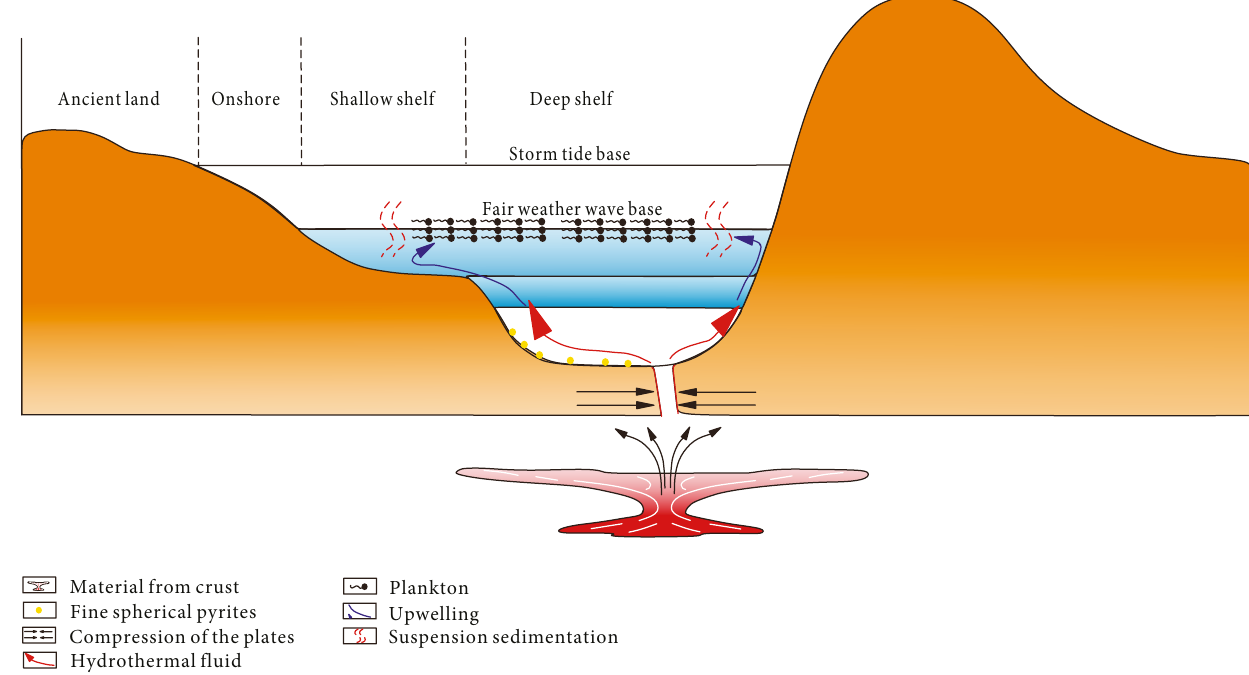
Figure 8: The mechanism underlying sedimentary organic matter enrichment in the upper Ordovician-lower Silurian shale from the upper Yangtze region. The water body was divided into upper and lower layers by a redox interface [55].